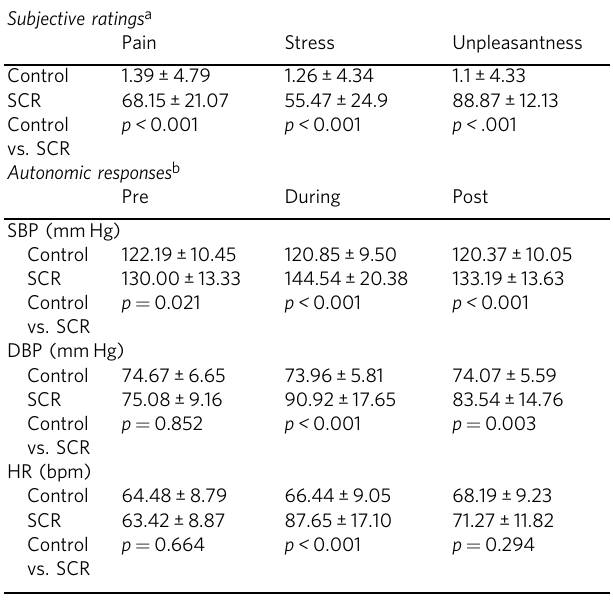
Values aremeans±SDs. N controlgroup = 27; N SCRgroup = 26. Subjective ratings weregiven on a 100mm visual analogue scale. Bpm beats per minute, DBP diastolic blood pressure, HR heart rate, SBP systolic blood pressure, SCR stress cortisol responders. a p -Values based on unpaired two-sample t -tests. b p -Valuesbased onpairwisecomparisons followingRMANOVAswith Bonferronicorrection for multiple comparisons. It is noteworthy that during the SECPT, the measurement pre-feet submersion is taken within the stressful context (including video monitoring), which likely contributed to the group difference in SBP observed at baseline.